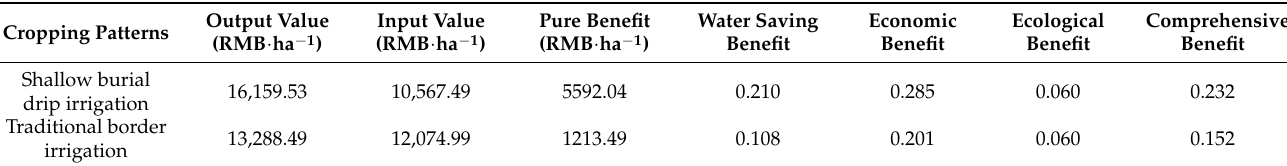
Table 5. Benefit analysis of comparative experiment in different planting patterns